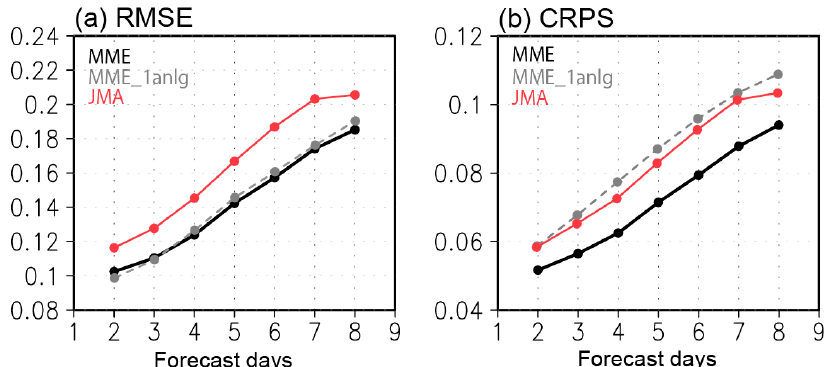
Figure 10. Same as Figure 8a,b, except for wind power generation forecasts, using a single analog method for MME (gray). JMA (red) and MME (black) are the same as in Figure 8.